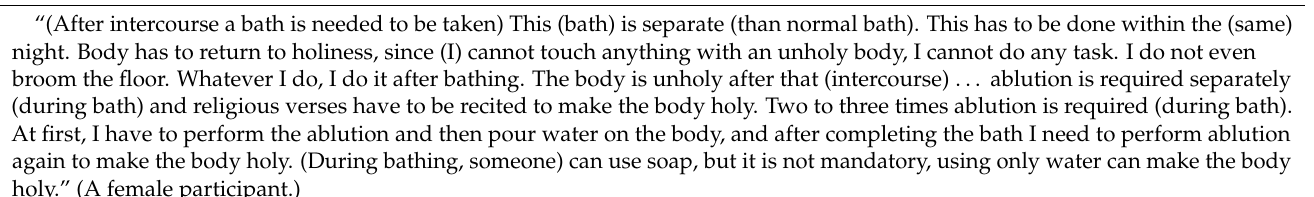
Table 3. Quotations regarding holiness from the study participants in Arichpur, Dhaka, from